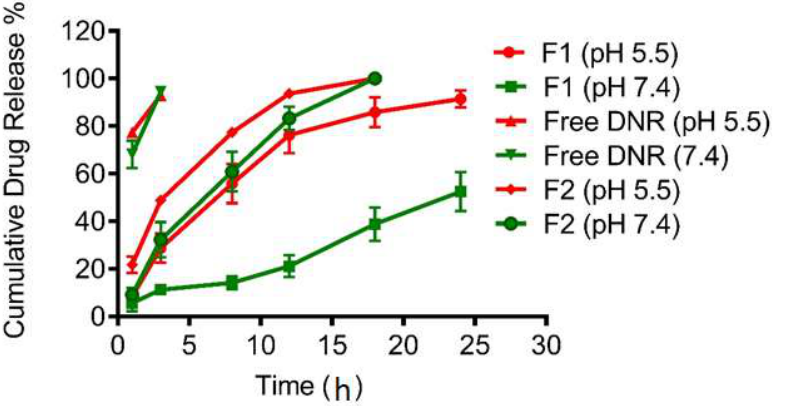
Figure 1. In vitro release profiles of DNR encapsulated liposomes. Values represent Mean ± SD, n =